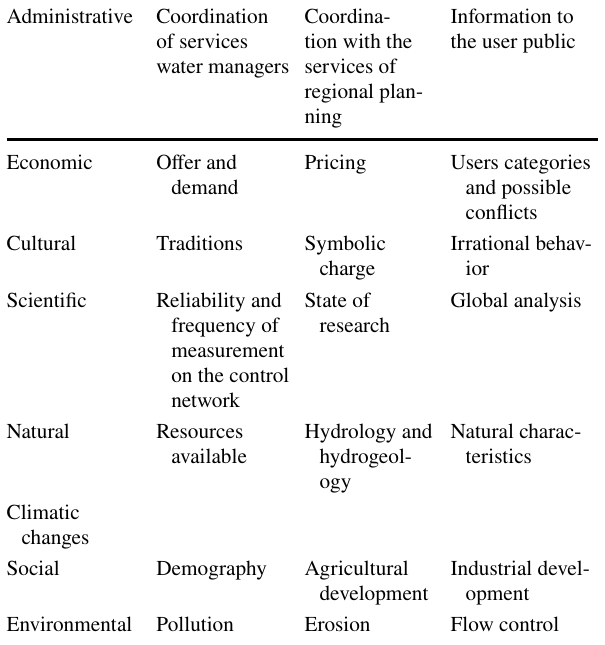
Table 2 Constraints and challenges of the system Administrative Coordination of services